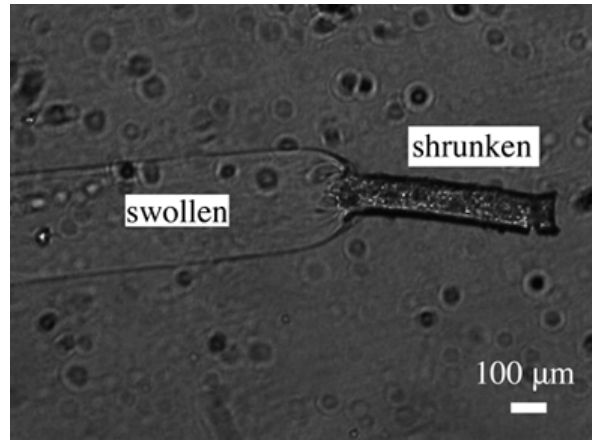
Figure 6. Coexistence of swollen and shrunken phases in the sulfonated SR gels at i = 2.8 and φ e = 0.71. This coexistence state lasted for several days.